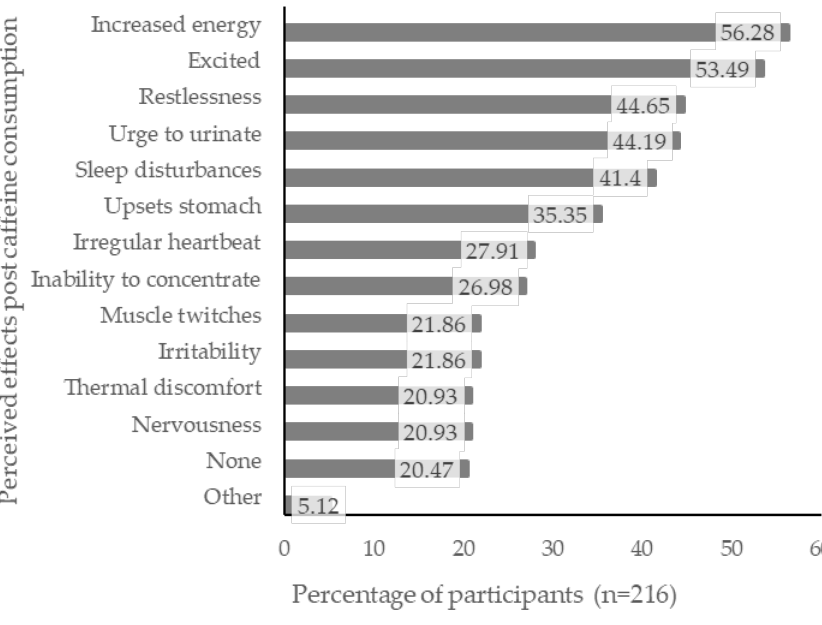
Figure 1. Self-reported “perceived effects” experienced post-caffeine consumption ( n = 216).